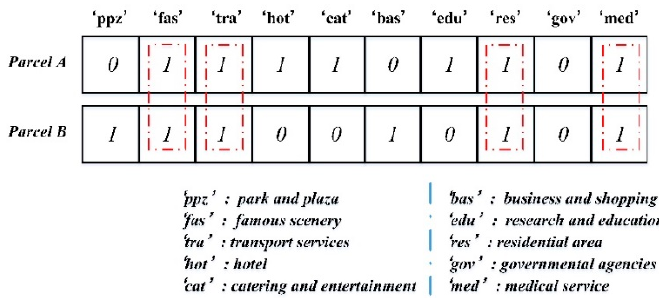
Figure 4. Illustration of imitation behaviours of urban parcels.